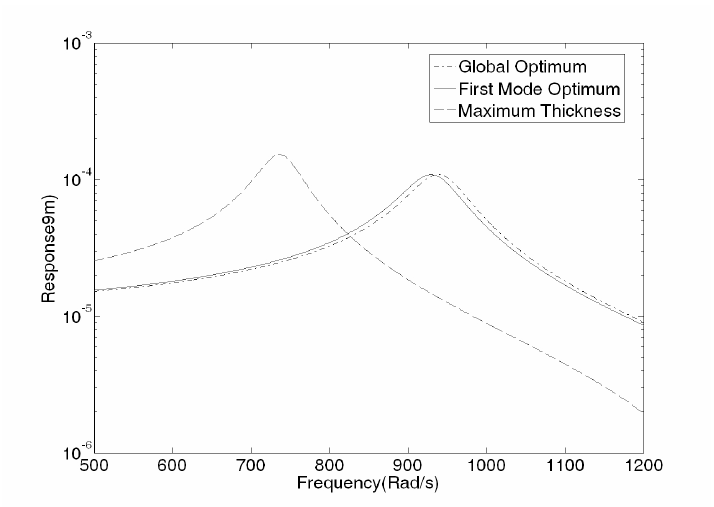
Fig. 12. Comparsion between the local optimum configuration for the first mode, the overall optimum configuration and the configuration with maximum thickness of damping layer and constraining layer. The visco and constraining layer thicknesses for the local optimum are 0.00025 m and 0.002 m, and for maximum thickness configuration are 0.002 m and 0.002 m, respectively.